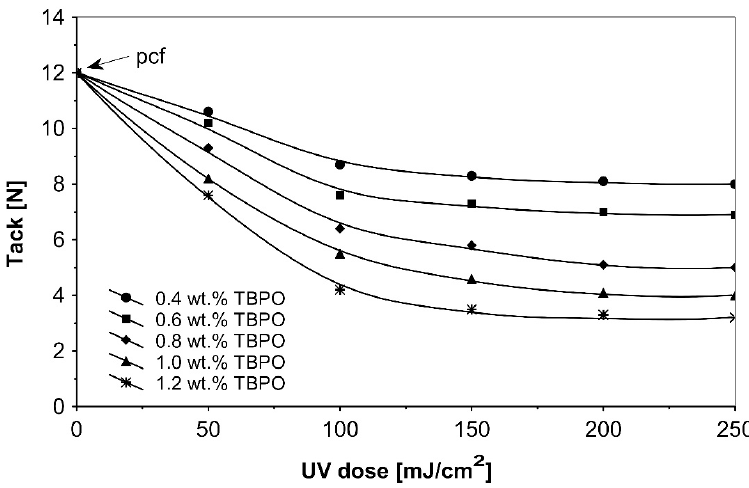
Figure 8. Tack versus UV dose for the use of tris-benzophenyloxy phosphineoxide (TBPO).